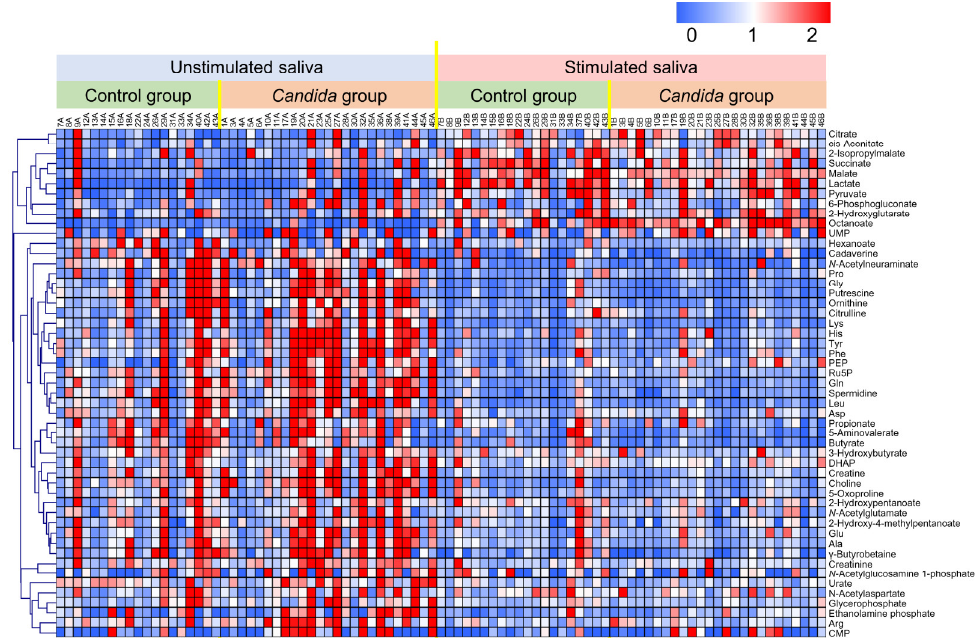
Figure 1. Heat map of metabolites detected in participants’ unstimulated and stimulated saliva. The 51 metabolites frequently detected in >50% of all samples are visualized. The concentration of each metabolite is divided by its average concentration. Clustering was conducted based on Pearson correlation. Metabolites with low and high concentrations are shown in blue and red,